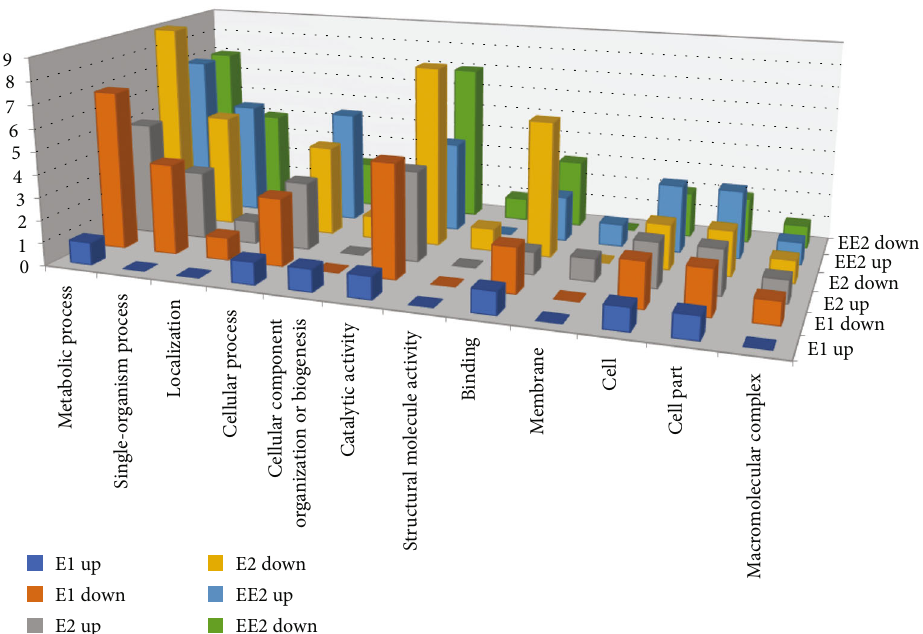
Figure 4: GO functional enrichment histogram of strain R-001 under di ff erent estrogen conditions. Table 2: DEGs related to estrogen degradation by R-001under di ff erent estrogen treatment conditions. Gene